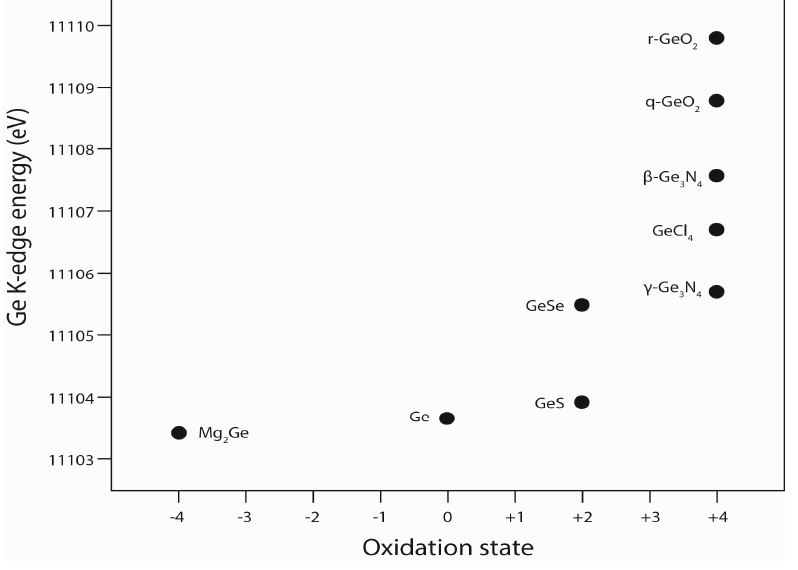
Figure 1. Ge K-edge for different germanium compounds (adapted from [23]).